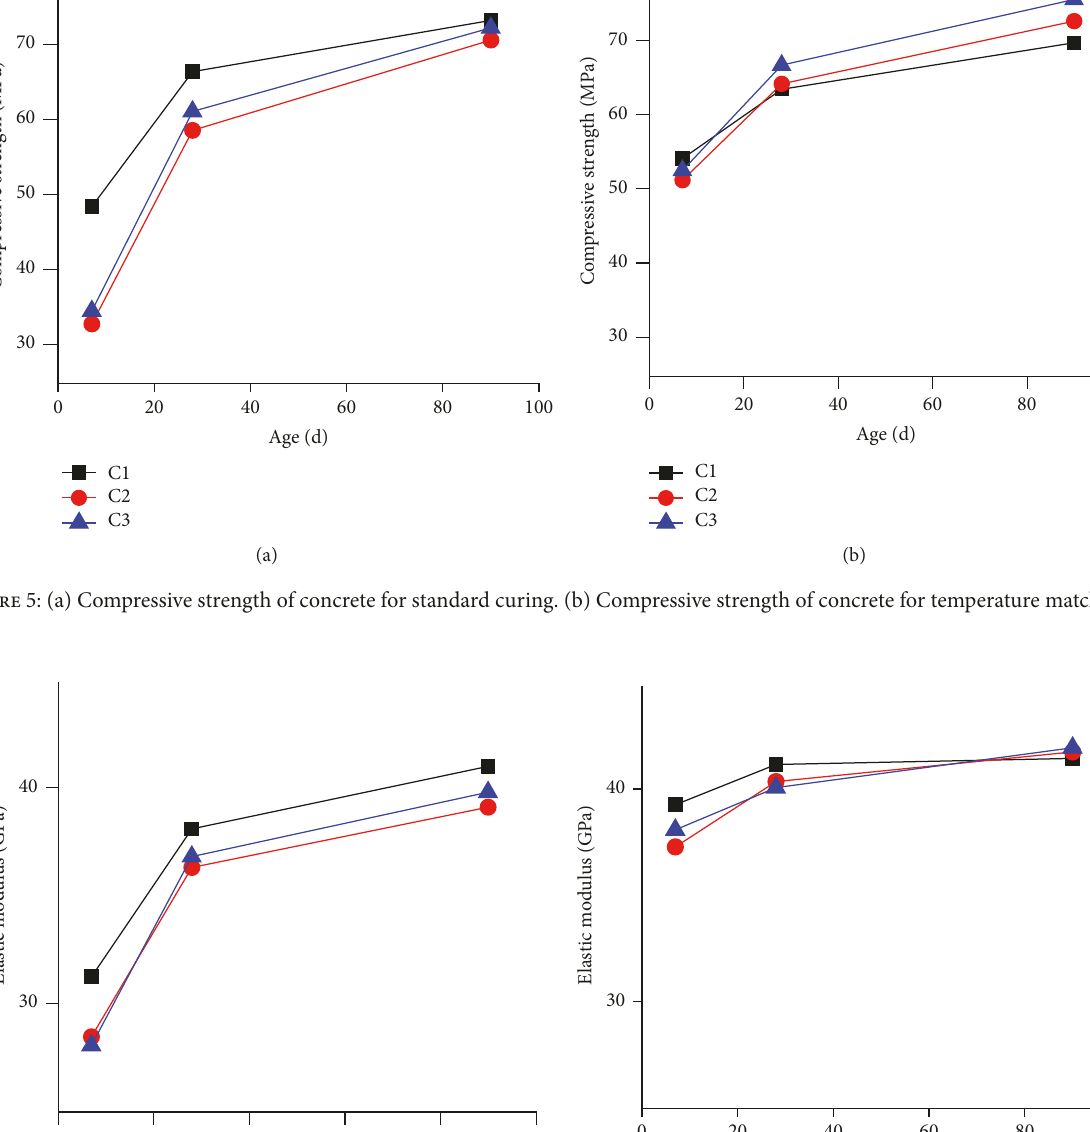
than that for plain cement concrete for standard